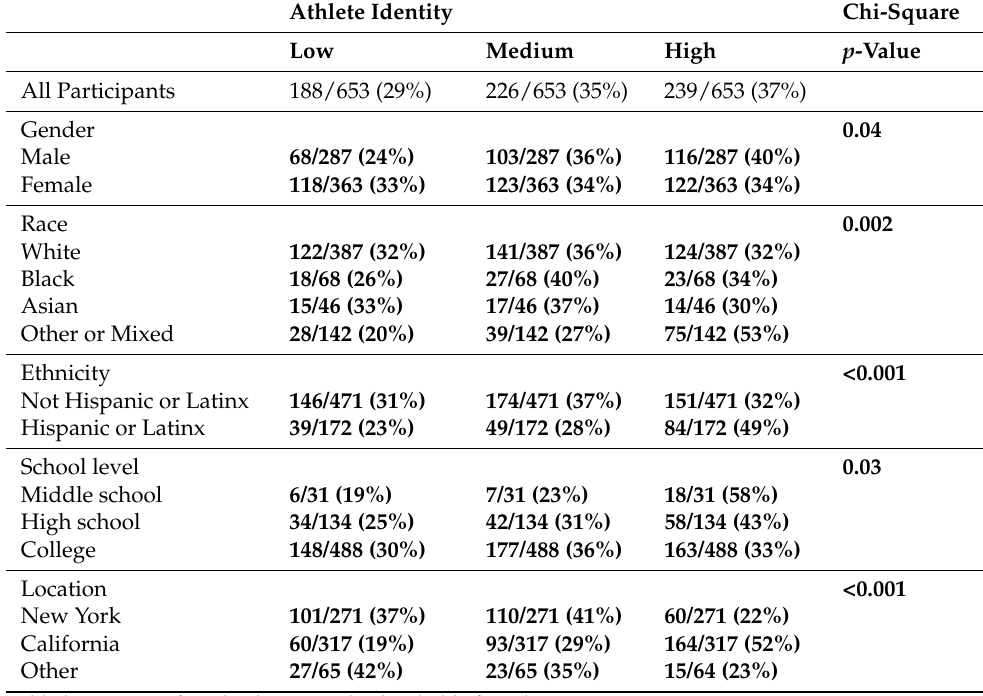
Table 2. Frequency of athletic identity tertiles by demographic variables.